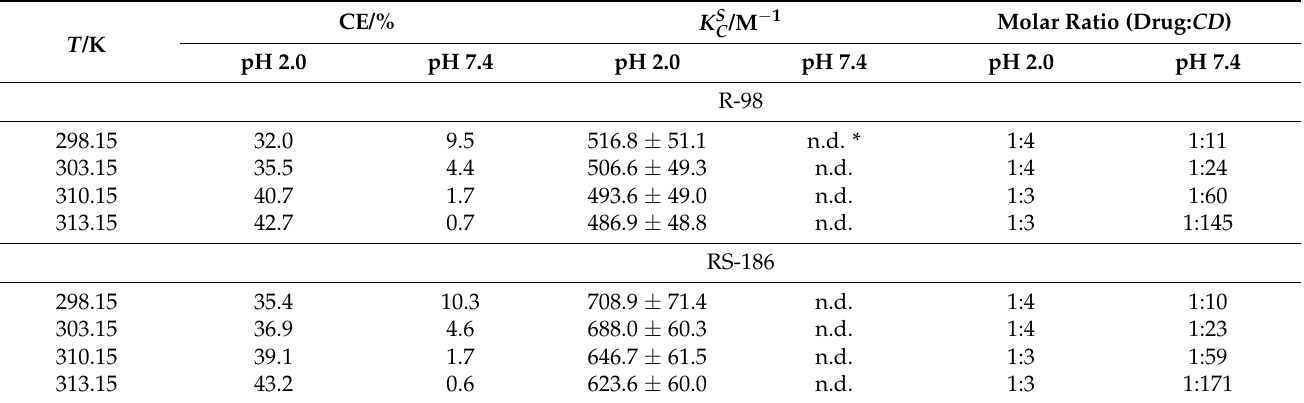
Table 2. Complexation efficiency (CE), apparent stability constant ( K S HP- β - CD ) at different temperatures and pressure p = 100